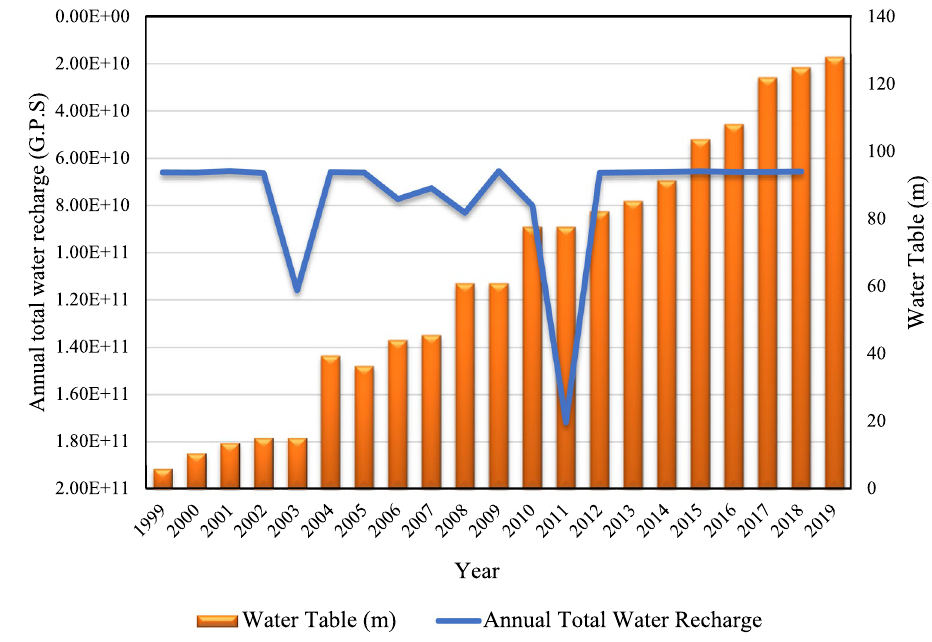
Fig. 21 Comparison between annual recharge and water table in the study area